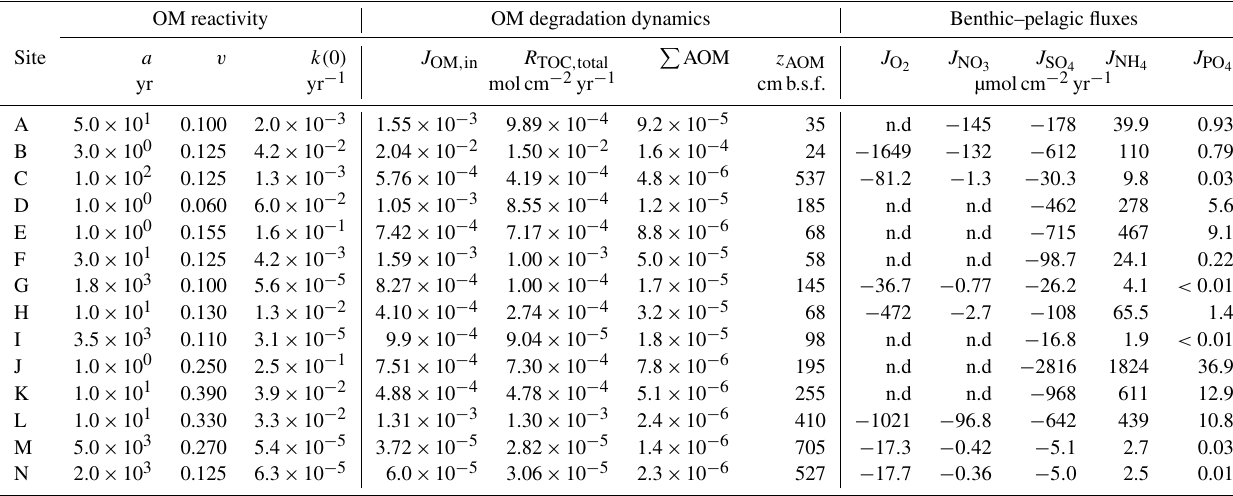
Table 6. Benthic organic matter dynamics derived from the coupled model–data assessments across the depositional settings. OM reactivity OM degradation dynamics Benthic–pelagic fluxes